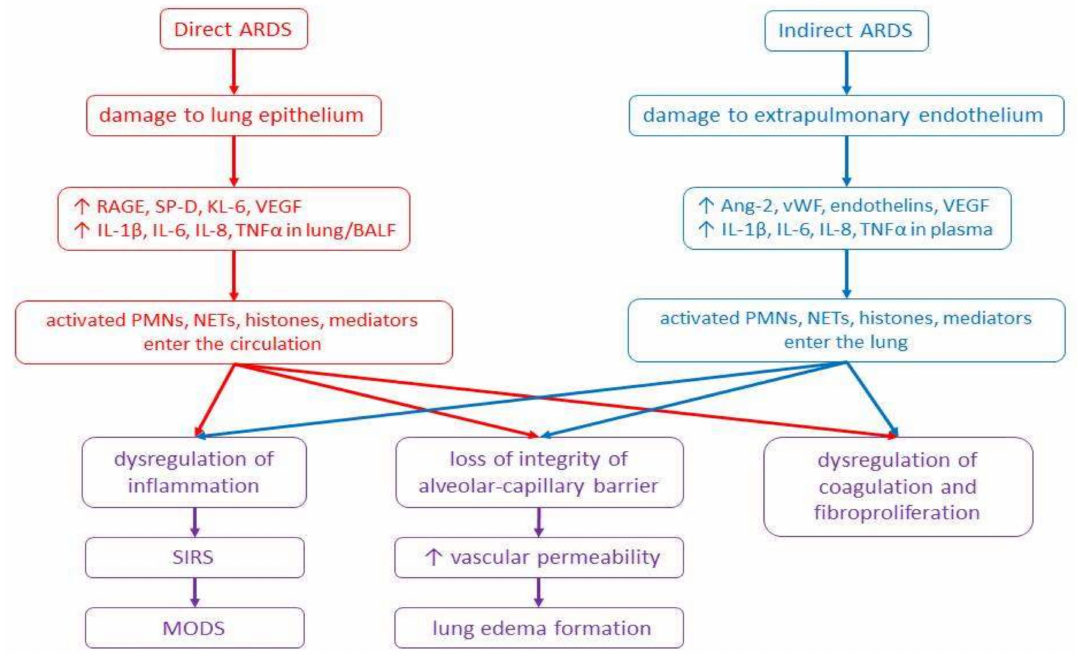
Figure 1. Scheme of pathomechanisms of direct and indirect forms of ARDS. Abbreviations: Ang-2: angiopoietin-2, ARDS: acute respiratory distress syndrome, BALF: bronchoalveolar lavage fluid, IL: interleukin, KL-6: Krebs von den Lungen-6, NETs: neutrophil extracellular traps, MODS: multiple organ dysfunction syndrome, PMNs: polymorphonuclears, RAGE: receptor for advanced glycation end-products, SIRS: systemic inflammatory response syndrome, SP-D: surfactant protein D, TNF α : tumour necrosis factor alpha, VEGF: vascular endothelial growth factor, vWF: von Willebrand factor, ↑ :